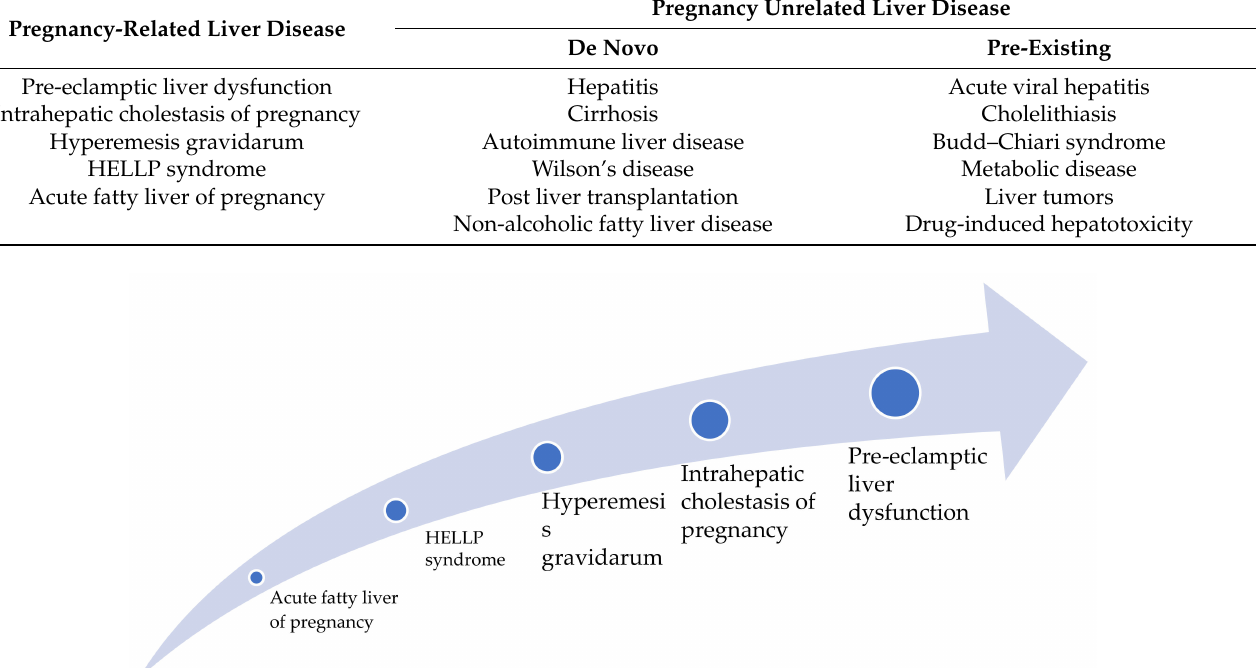
Figure 1. The direction of increased incidence of pregnancy-related liver disease. Data from Ref [7]. Pregnancy-related liver disease is dependent on the trimester, as opposed to those which are not pregnancy-related, which can occur at any time, independent of the trimester of pregnancy. The establishment of the diagnosis and therapeutic management depends on the moment of the symptoms’ onset and alterations of laboratory tests